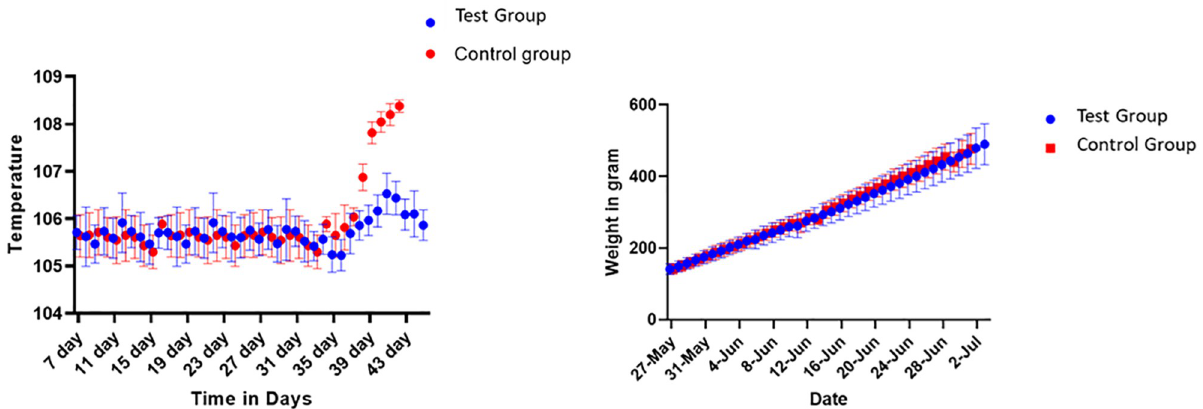
Fig 10. Ranigoldhunga ™ vaccine challenged trial in the test group (n = 14) and the Control group (n = 13). Measurement of increase in temperature (left) and change in body weight (right) of the chickens that were challenged intramuscularly (0.2 ml) with a total dose of Ge Genotype VII.2 105.3 EID 50 .